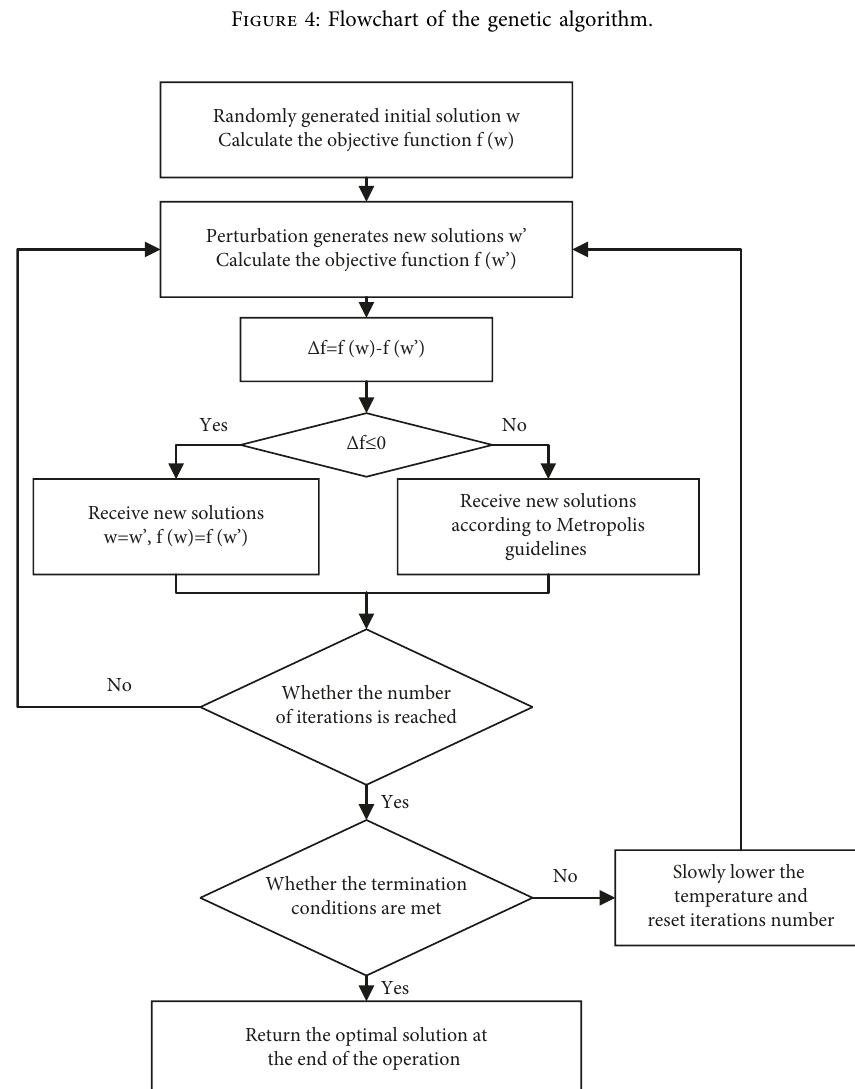
Figure 5: Flowchart of the simulated annealing